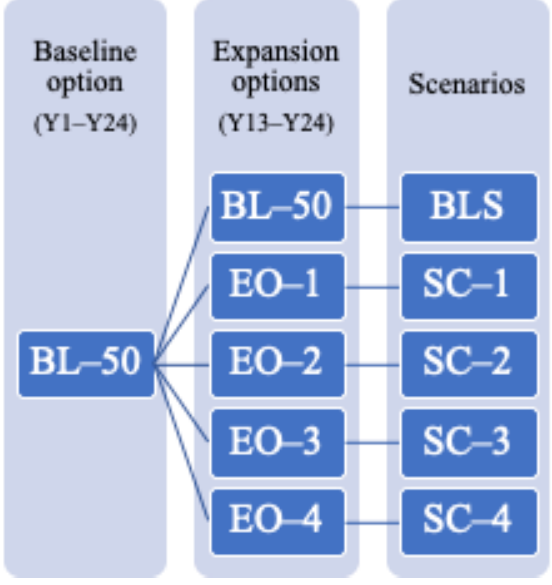
Figure 4. Baseline and expansion options scenarios.